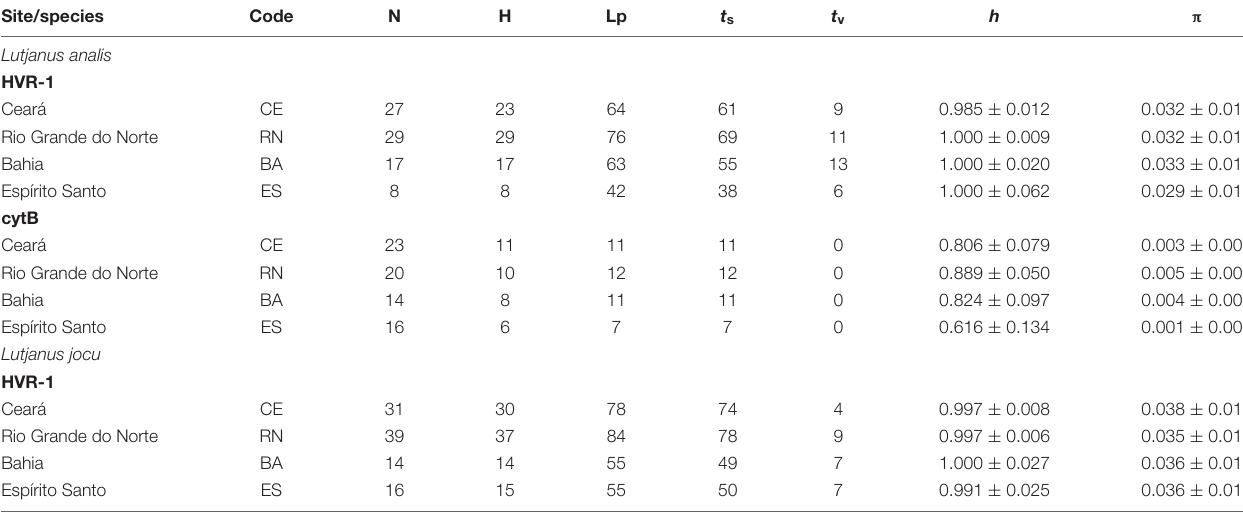
TABLE 2 | Molecular and genetic diversity characteristics among mtDNA sequences of Lutjanus analis and Lutjanus jocu by locality. Site/species Code